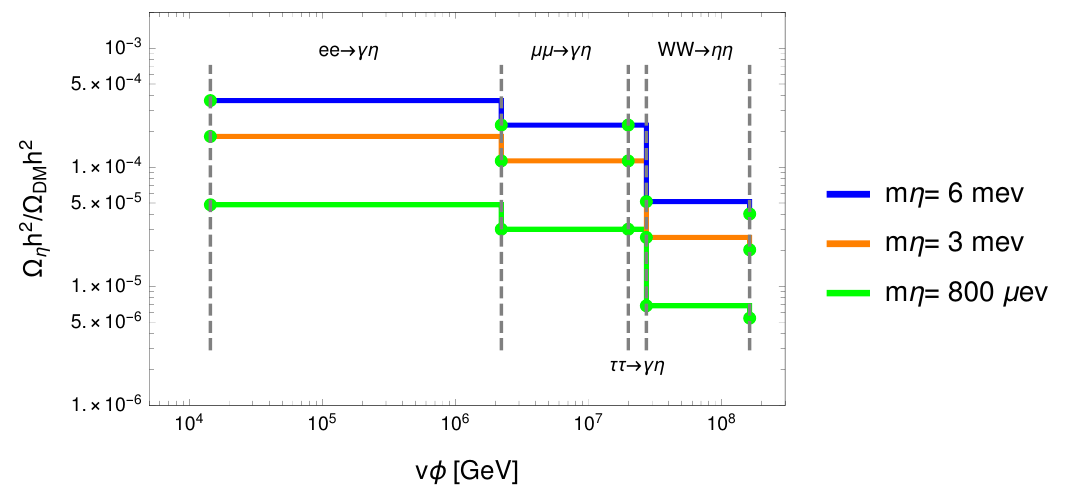
Figure 4 . Abundance of (cid:17) with respect to v (cid:30) , produced through the freeze-out process for di(cid:11)erent values of m (cid:17) . The gray dashed vertical lines indicate the v (cid:30) intervals and the corresponding main production